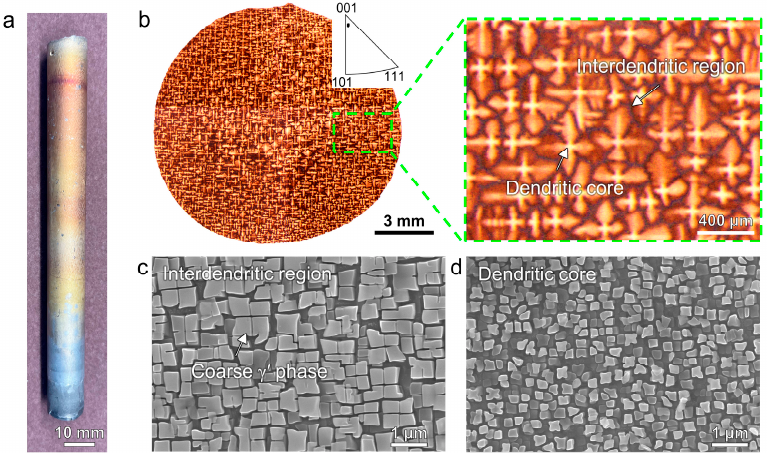
Figure 2. Photograph and cross-sectional microstructures of an as-grown Ni-based SX rod (3Ta6Al1Ti). ( a ) An SX rod; ( b ) Optical micrograph and inverse pole figure (inset) of the cross-section of the SX alloy, indicating that growth direction is along the [001] direction. SE images show that the γ′ phase in the interdendritic region ( c ) is larger than that in the dendritic core ( d ).